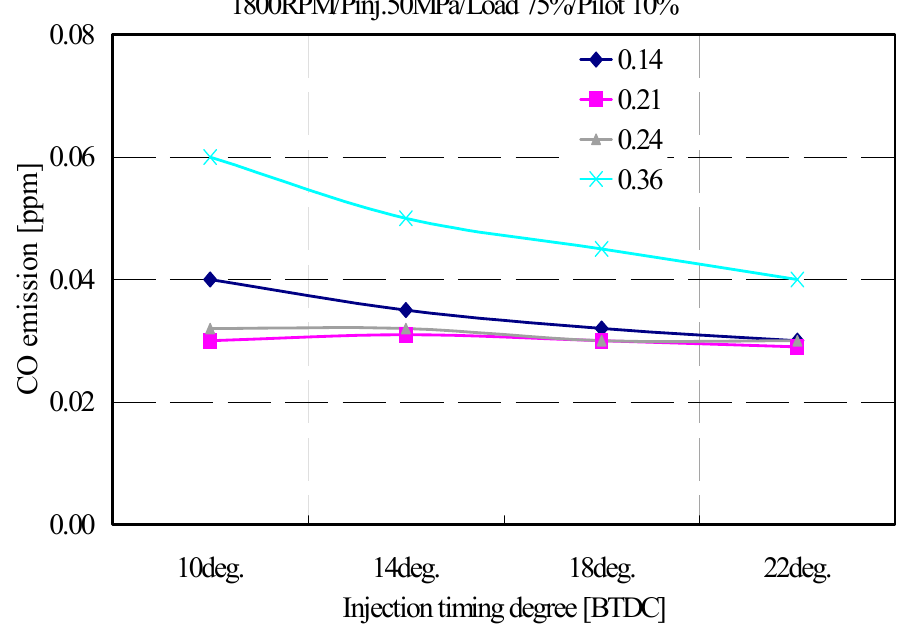
Figure 17. CO emission characteristics of DME engines with nozzle needle lift as a function of injection timing degree.